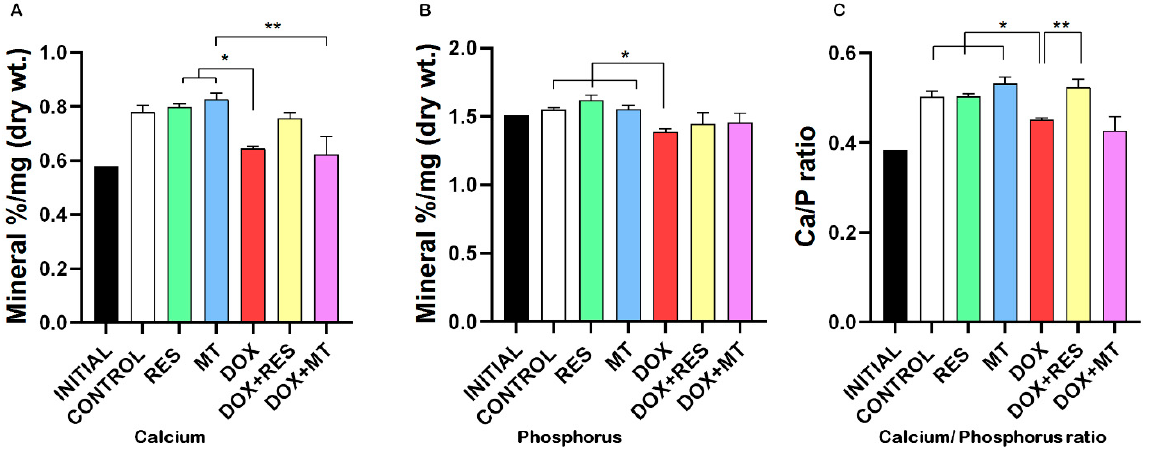
Figure 7. Mineral analysis of gilthead seabream fed with microdiets. Calcium ( A ), phosphorus ( B ), calcium/phosphorus ratio ( C ). One-way ANOVA, Tukey’s multiple comparisons test, *— p ≤ 0.05, **— p ≤ 0.01. Acronyms: resveratrol (RES), doxorubicin (DOX), MitoTEMPO (MT), doxorubicin + resveratrol (DOX+RES), and doxorubicin + MitoTEMPO (DOX+MT).